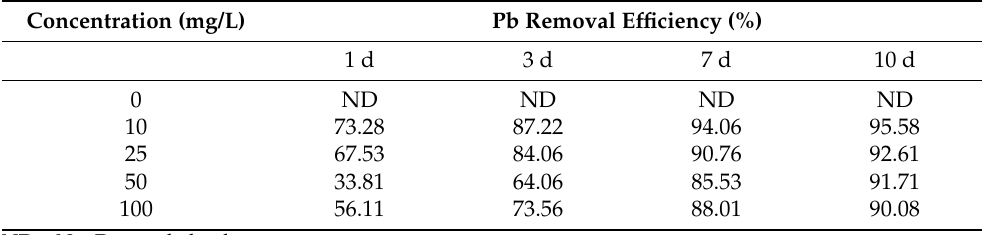
Table 2. The removal efficiency of lead. by L. Stolonifera in different concentrations of lead for different exposure